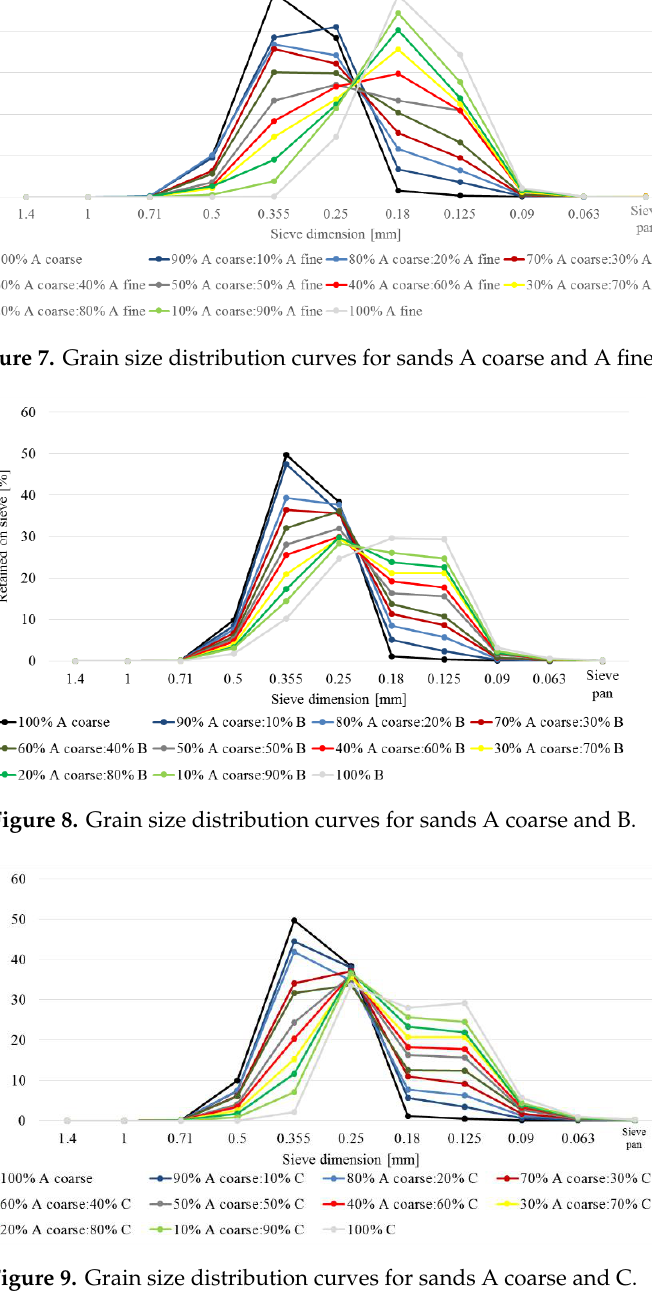
Figure 8. Grain size distribution curves for sands A coarse and B. Table 3. Basic properties of sands A coarse and B.